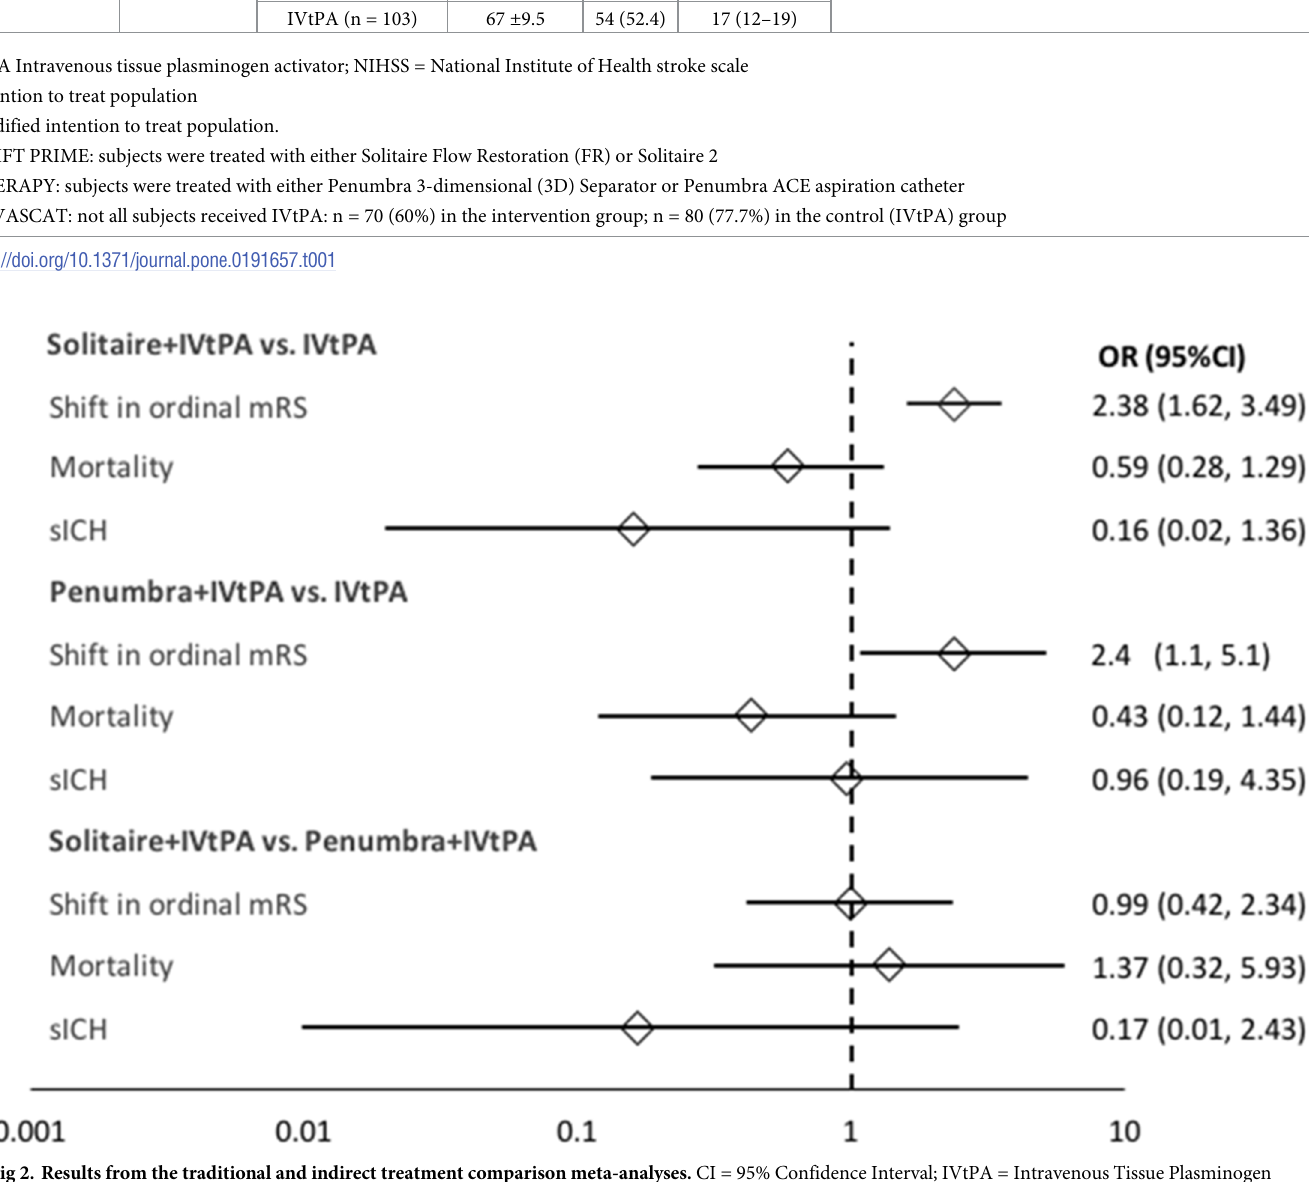
Fig 2. Results from the traditional and indirect treatment comparison meta-analyses. CI = 95% Confidence Interval; IVtPA = Intravenous Tissue Plasminogen Activator; mRS = modified Rankin Score; OR = Odds Ratio; sICH = Symptomatic Intracranial